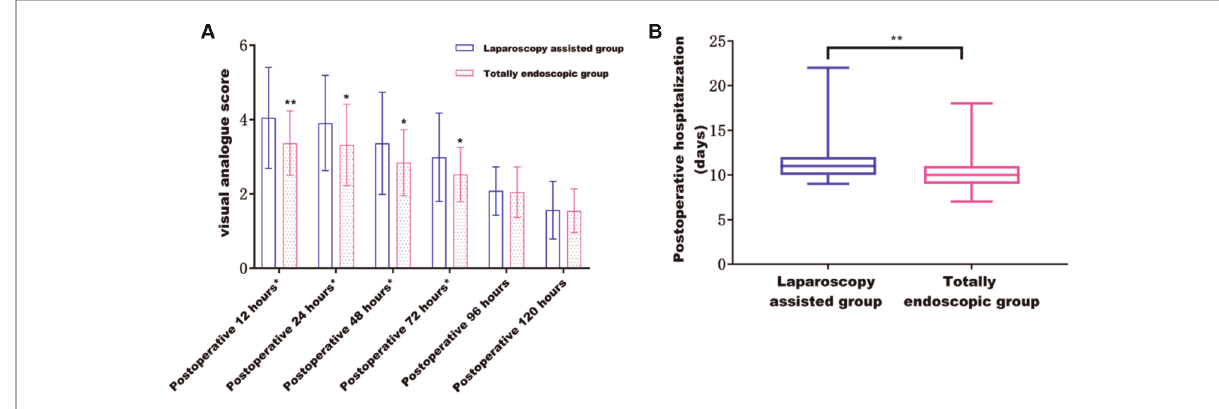
FIGURE 5 ( A ) Effect of different surgical methods on postoperative pain from 12 to 120 h; ( B ) effect of different surgical methods on postoperative hospital